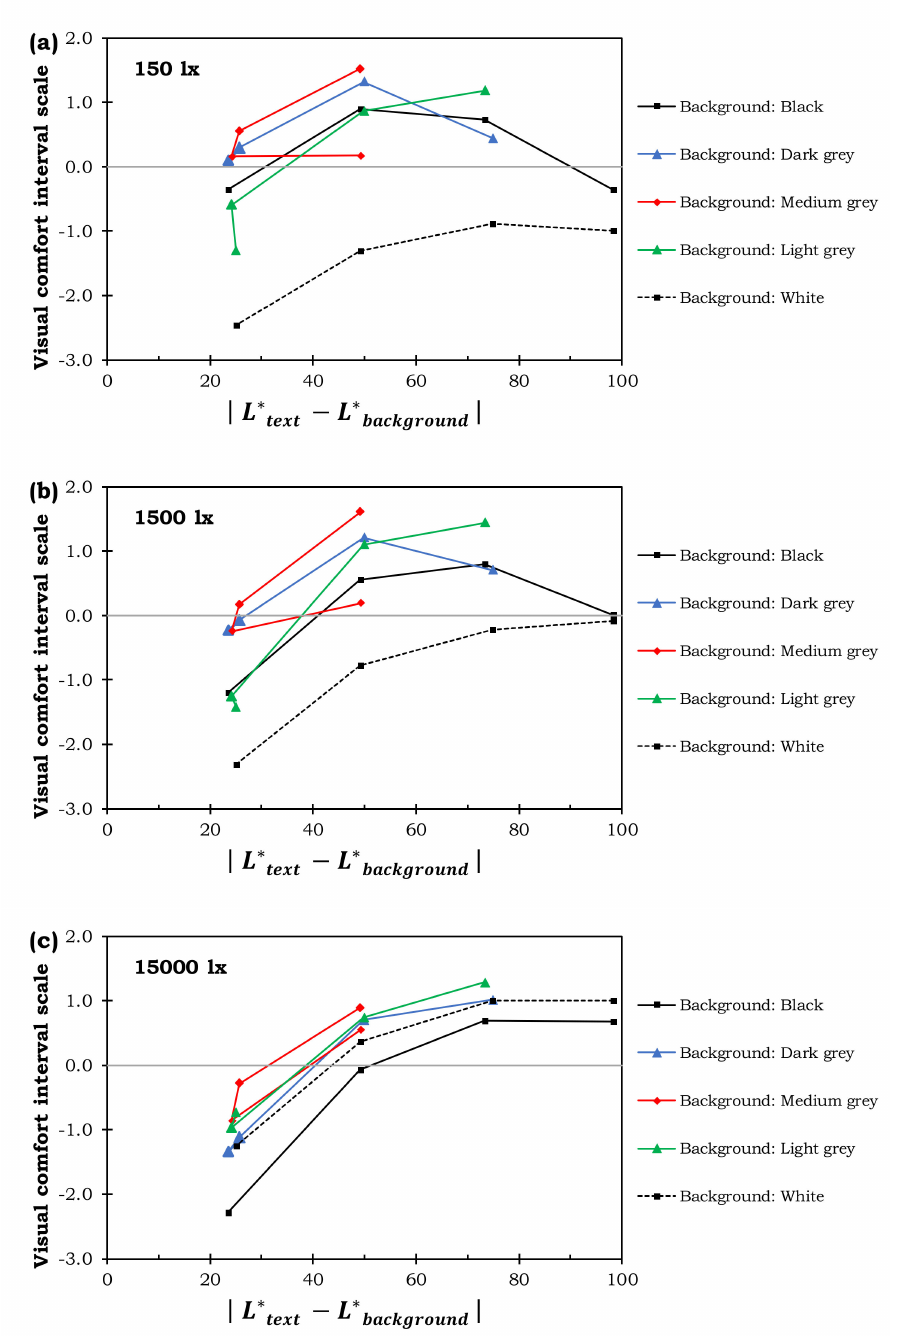
Figure 5. Visual comfort interval scale of the 20 text-background combinations under: ( a ) 150 lx; ( b ) 1500 lx; and ( c ) 15,000